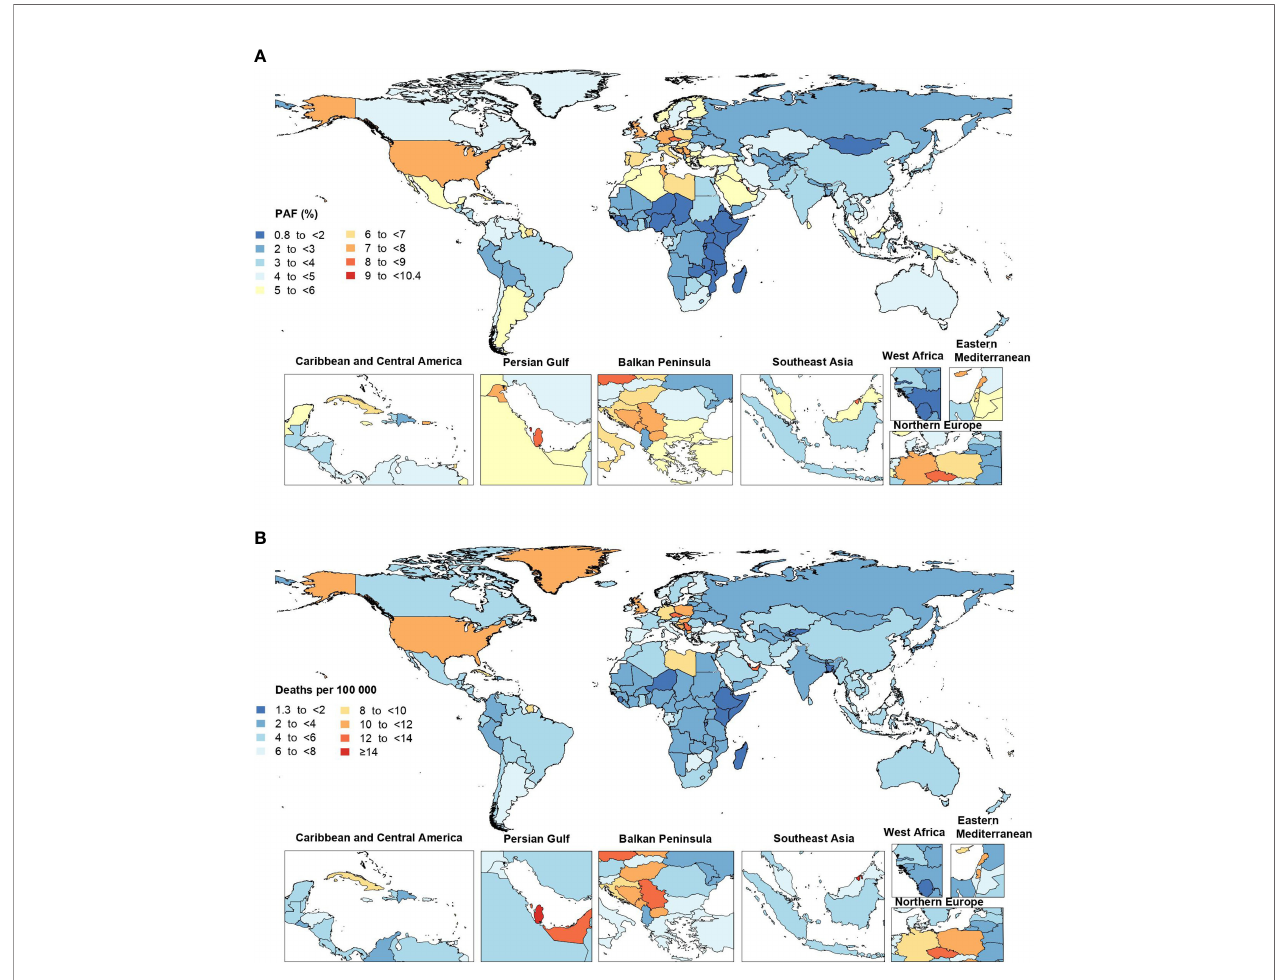
FIGURE 2 | Population attributable fraction (PAF) (A) and age-standardized rates (B) of cancer deaths attributable to high fasting plasma glucose in 2019, by country. (Generated from data available from